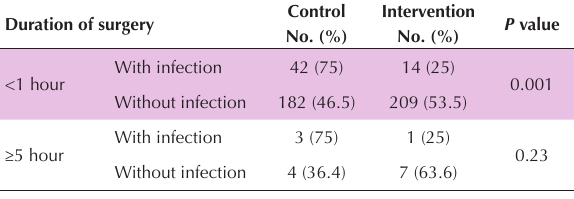
Table 5. Incidence of cesarean section infection by duration of surgery Duration of surgery